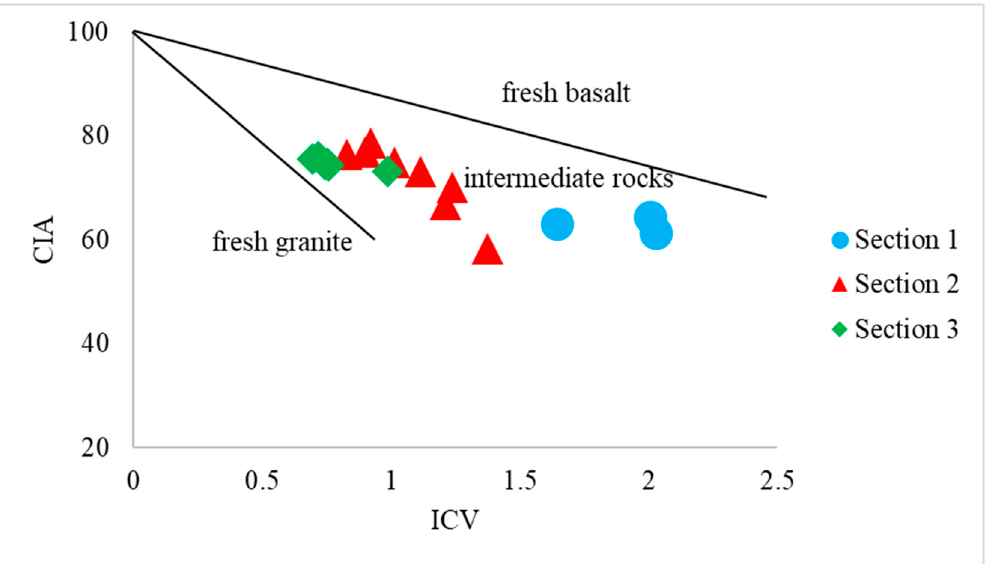
Figure 13. Weathering indicators, the Chemical Index of Alteration (CIA), and the Index of Chemical Variation (ICV) in Chichali Formation